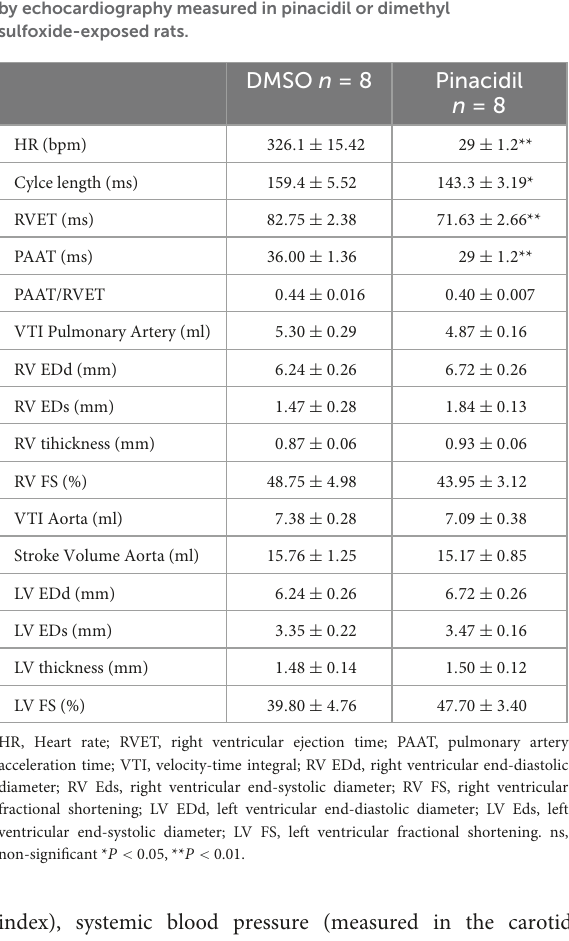
pressure ( Figure 7F ) and other morphometric